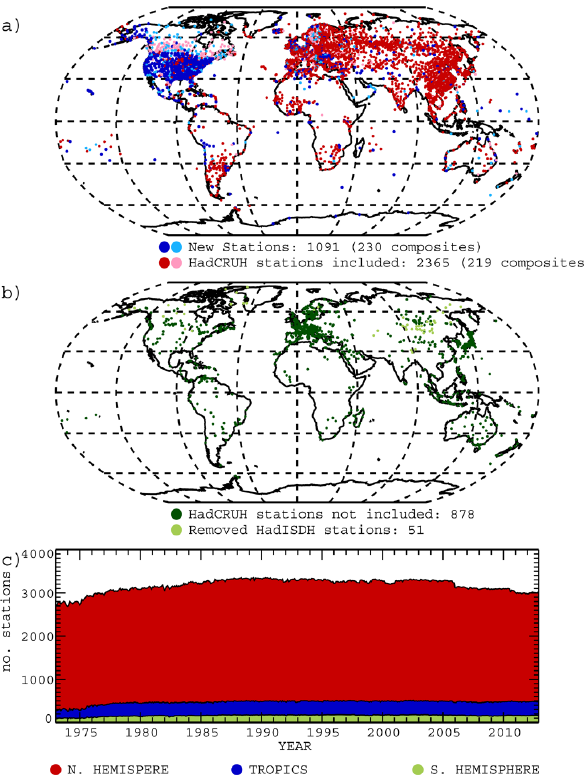
Fig. 1. Station coverage comparison between HadCRUH and HadISDH. (a) Station coverage in HadISDH. Stations in red/pink were also in HadCRUH. Stations in blue/turquoise are new. Pink and turquoise stations are stations that are composites of more than one original source station. (b) Stations from HadCRUH that are no longer in HadISDH (dark green), and HadISDH sta- tions with subzero specific humidity issues after homogenisa- tion that are not included in any further analyses (light green). (c) Station coverage by month for HadISDH, coloured by re- gion (Northern Hemisphere=20 ◦ N–90 ◦ N, tropics=20 ◦ S–20 ◦ N, Southern Hemisphere=20 ◦ S–90 ◦ S). The tail-off from 2006 on- wards is likely due to ongoing improvements to the ISD historical archive. Station coverage should improve over this period with fu- ture updates of